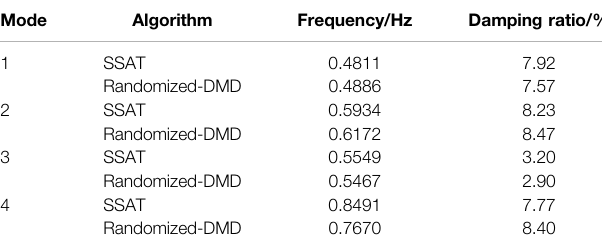
TABLE 5 | Identi fi cation results for the R-M-ANN model with different ambient excitations for the 16-generator 5-area